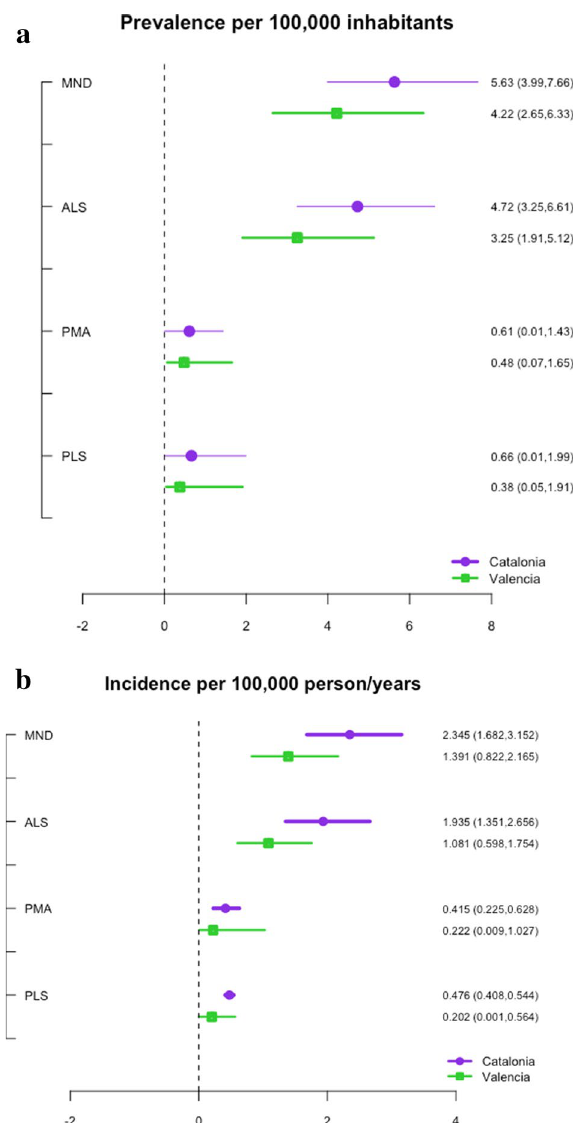
Figure 2. ( a ) Forest plot of the estimated prevalence per 100,000 inhabitants in Catalonia and Valencia. ( b ) Forest plot of the estimated incidence per 100,000 person-years in Catalonia and